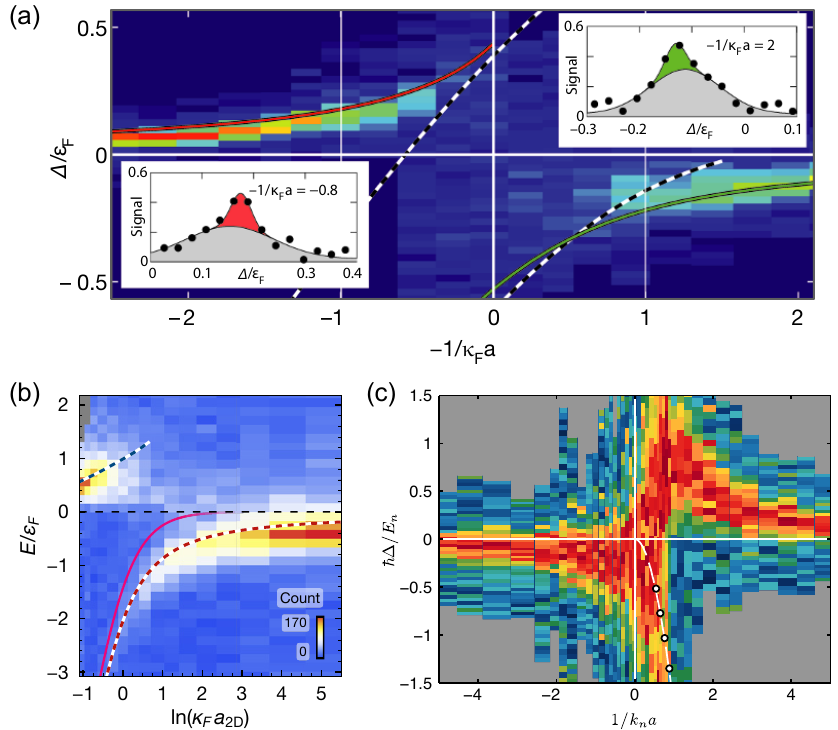
Figure 2. Experimental RF injection spectroscopy of impurities immersed in different media: ( a ) a three-dimensional (3D) Fermi gas [16], ( b ) a two-dimensional (2D) Fermi gas [26], and ( c ) a 3D Bose-Einstein condensate [35]. For the 3D and 2D fermionic backgrounds, the impurity-medium interaction strength is encoded by the dimensionless parameters 1/ k F a and log ( k F a 2D ) , and are tuned via a narrow Feshbach resonance [16] and an orbital Feshbach resonance [26], respectively. The vertical energy scale is normalized to E F and the zero corresponds to the frequency of the atomic RF transition in the absence of the medium. The repulsive polaron energy branch is clearly visible in all cases at positive RF detuning, ceasing to be well defined upon approaching unitarity-limited interactions from the repulsive side, i.e., a > 0 or ln ( k F a 2 D ) < 0. Panel ( a ) is adapted from Ref. [16], panel ( b ) from Ref. [26], and panel ( c ) from Ref.